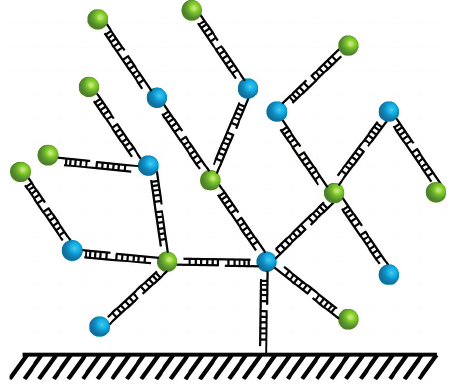
Figure 15. Schematic of surface-tethered induced aggregation, where the presence of a target nucleotide sequence would induce binding of a QD to a surface. The surface-tethered QD would have multiple additional binding sites available for further target binding and additional QDs labeled with complimentary sequences. Such a design is proposed as a means with which to take advantage of the multivalancy of both the donor and acceptor in QD-QD FRET. Schematic is not drawn to